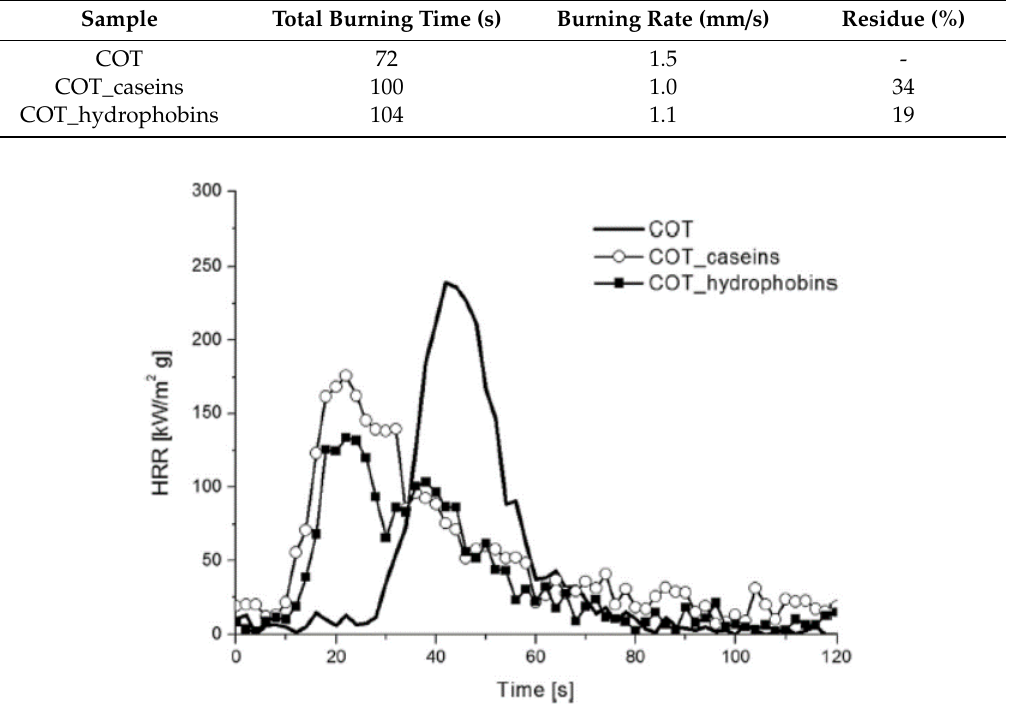
Table 1. Vertical burning results for casein and hydrophobin-treated cotton [36].